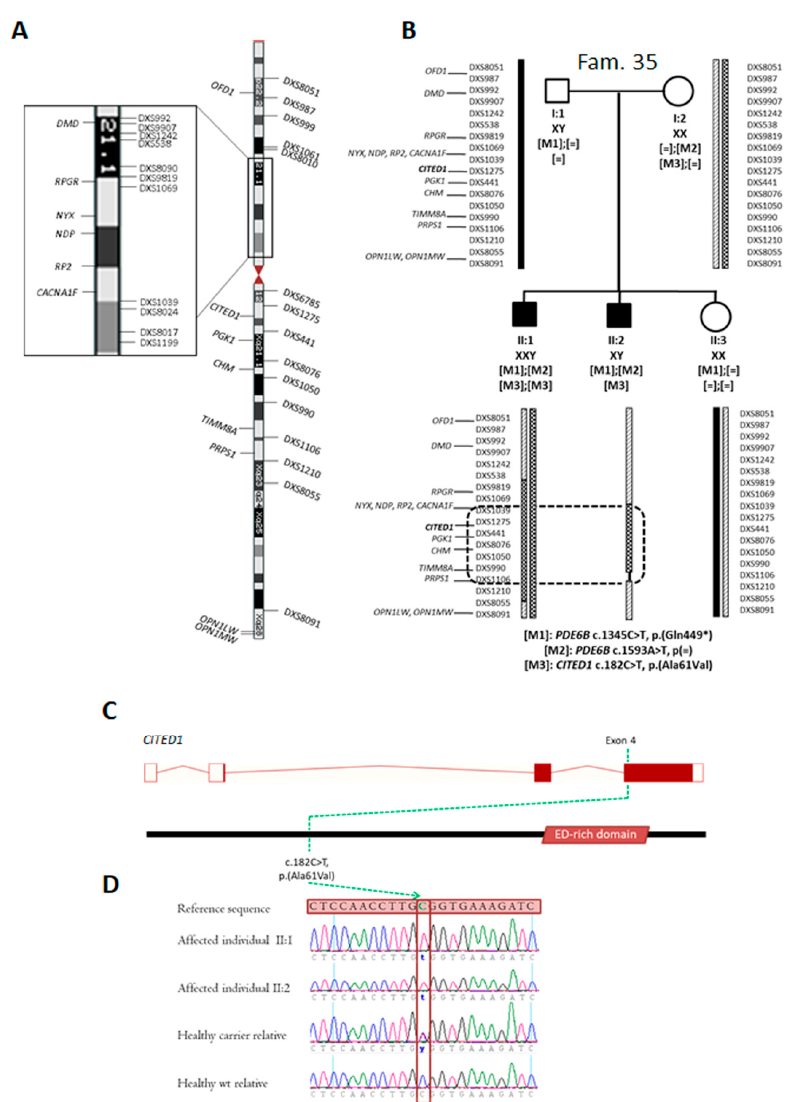
Figure 3. Segregation studies, linkage analyses and schematic representation of candidate variants detected in Family 35. ( A ) Diagram of chromosome X, showing the location of the used STR markers, X-linked IRD genes and the candidate gene CITED1. The region including RPGR is highlighted for clarity reasons. ( B ) Linkage analysis and segregation studies. Segregation analyses of PDE6B (M1 and M2) and CITED1 (M3) variants, detected by panel sequencing and whole exome sequencing, respectively, are shown. X-linked IRD associated genes and CITED1 (in bold letters) are indicated. Only those microsatellite markers (18 out of 26) adjacent to IRD genes or recombination points are displayed. Paternal X-chromosome is colored in black, while maternal X-chromosomes are marked by striped and checkered patterns, respectively. In individual II:2, linkage results did not allow determining whether the recombination between DXS990 and DXS1210 markers occurs upstream or downstream of the DXS1106 marker, which is shown with a thin black line. The black doted box contains the maximum common region between affected brothers, not shared by their healthy sister. ( C ) Genomic and protein location of the segregating variant in the CITED1 gene, which is composed of four exons (NM_001144885). Coding exons are shown as filled boxes while unfilled boxes reflect UTRs. The protein depiction was performed according to Uniprot, showing the glutamic acid / aspartic acid-rich domain (ED-rich domain) that characterizes the CITED family. The location of the identified CITED1 mutation is stated with a broken green line. ( D ) Electropherograms illustrating the detected CITED1 variant both in hemizygous / homozygous (affected individuals) and heterozygous (carrier female) state, as well as the wild type